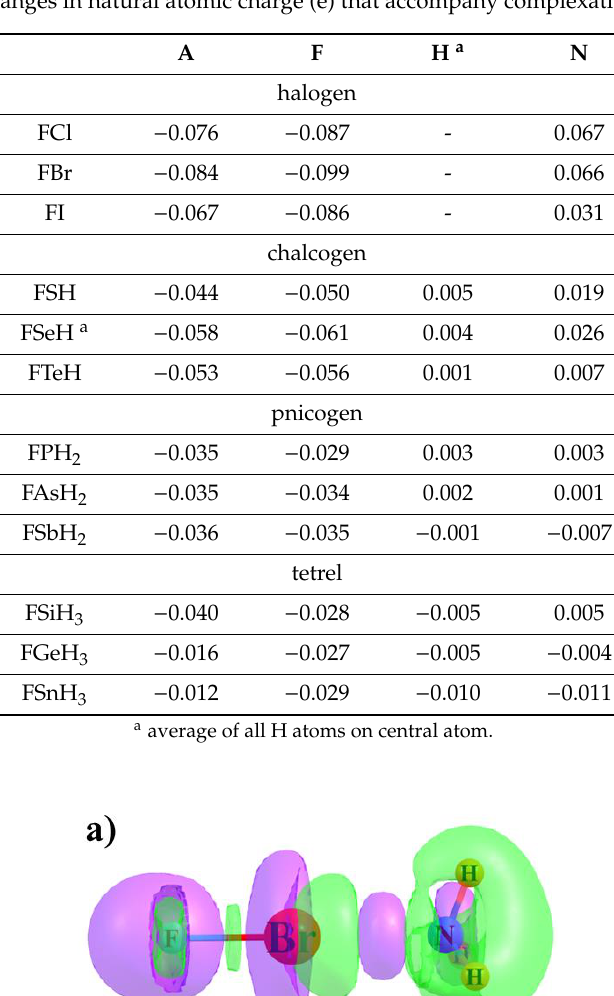
Table 3. Changes in natural atomic charge (e) that accompany complexation with NH 3 .